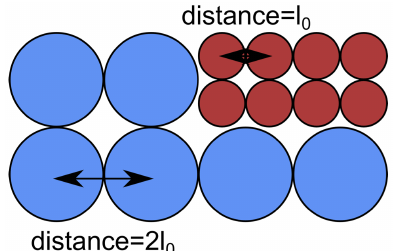
Figure 1. Sample particle configuration in a multi-resolution domain.